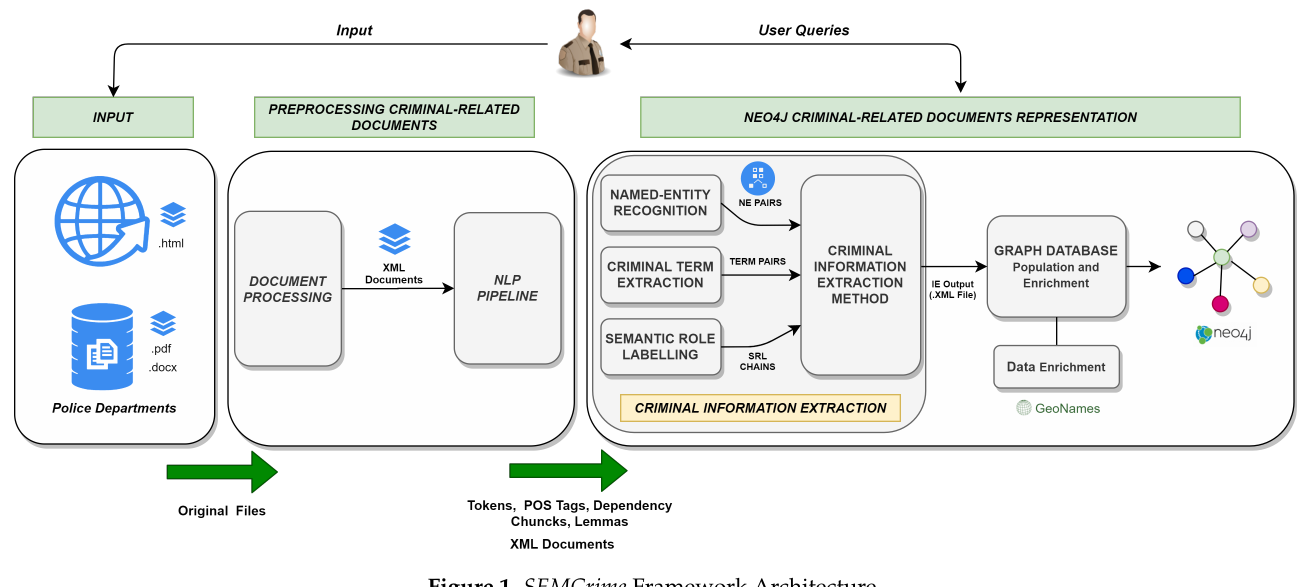
Figure 1. SEMCrime Framework